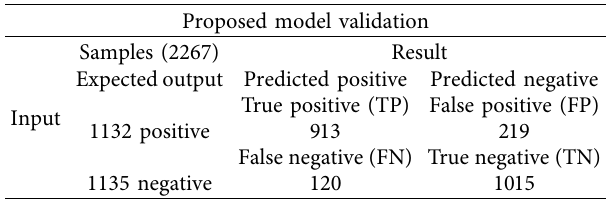
Table 2: Proposed model validation during the prediction of 5G congestion (SVM).